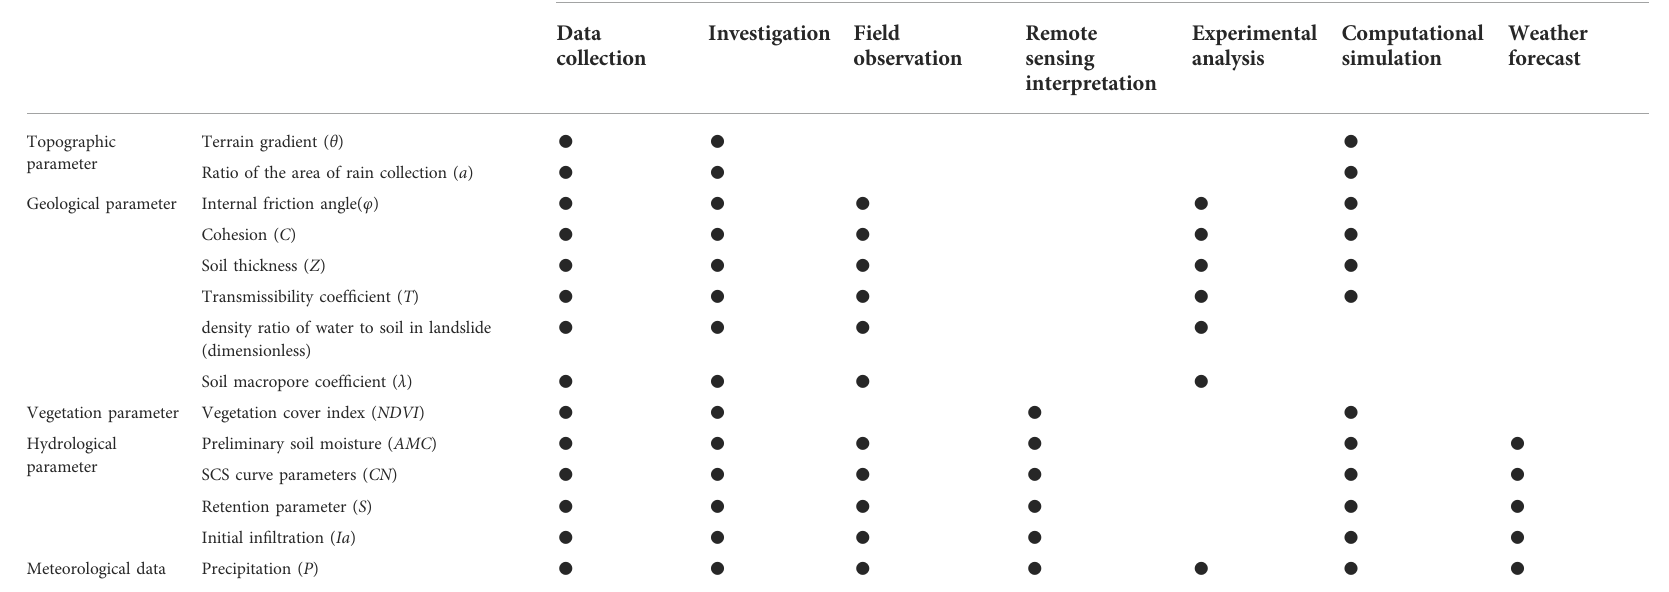
TABLE 3 Method of obtaining the key parameters of the proposed physical model of shallow